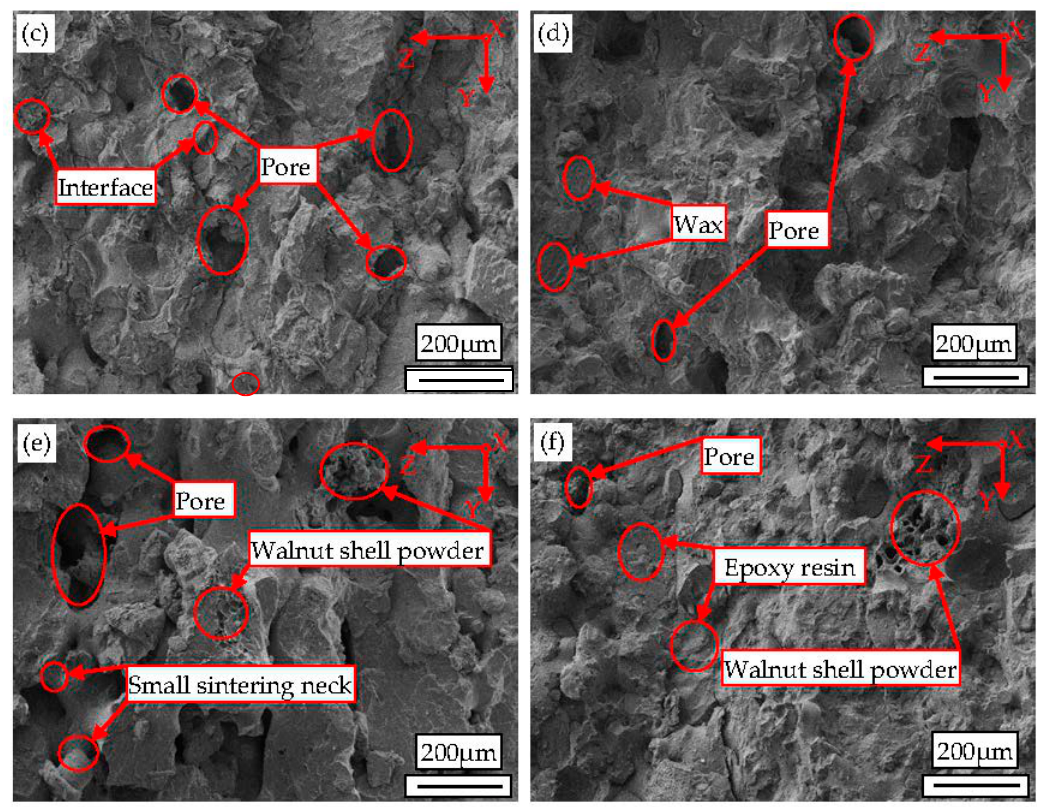
Figure 7. The scanning electron microscopy (SEM) diagrams of cross-sections of WSPC parts and after-treatment parts with different ingredient proportions: ( a ) WSPC parts (22% walnut shell powder); ( b ) WSPC parts (40% walnut shell powder); ( c ) WSPC wax-permeated parts (22% walnut shell powder); ( d ) WSPC wax-permeated parts (40% walnut shell powder); ( e ) WSPC